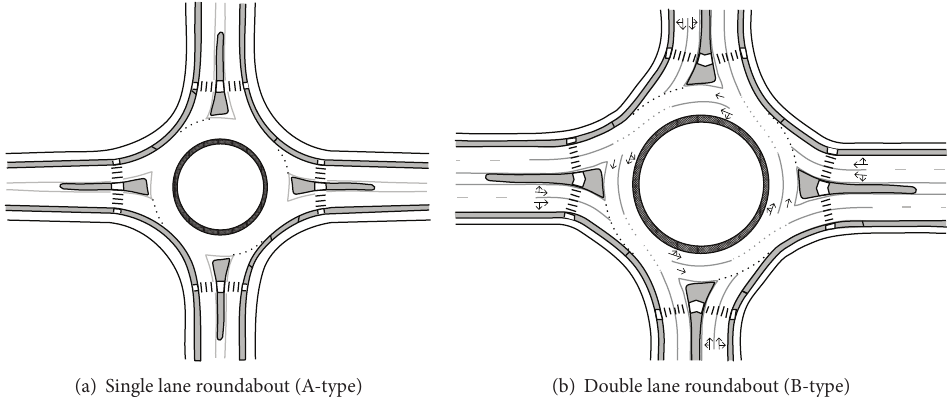
Figure 1: Two types of